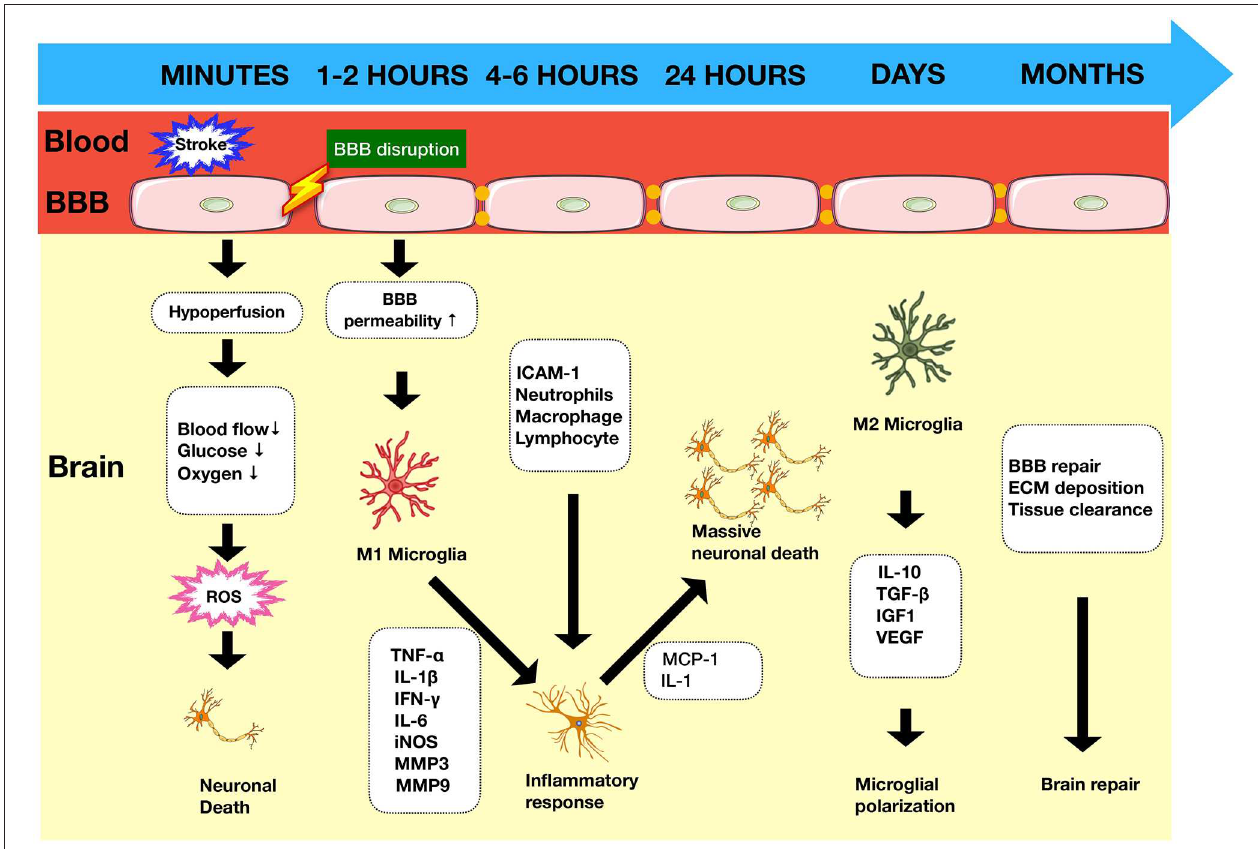
FIGURE 1 | Timeline of immune response in ischemic stroke. Ischemic stroke begins with a cascade of events as a result of arterial occlusion leading to hypoxia accompanied by ROS production within minutes and glucose deprivation. The integrity of the BBB is compromised leading to increased permeability within 1–2h, allowing infiltration of circulatory cells which contribute to the inflammatory process and exacerbate neuronal death. BBB, blood–brain barrier; ROS, reactive oxygen species; MMPs, matrix metalloproteinases; DAMPs, damage-associated molecular patterns; ECM, extracellular